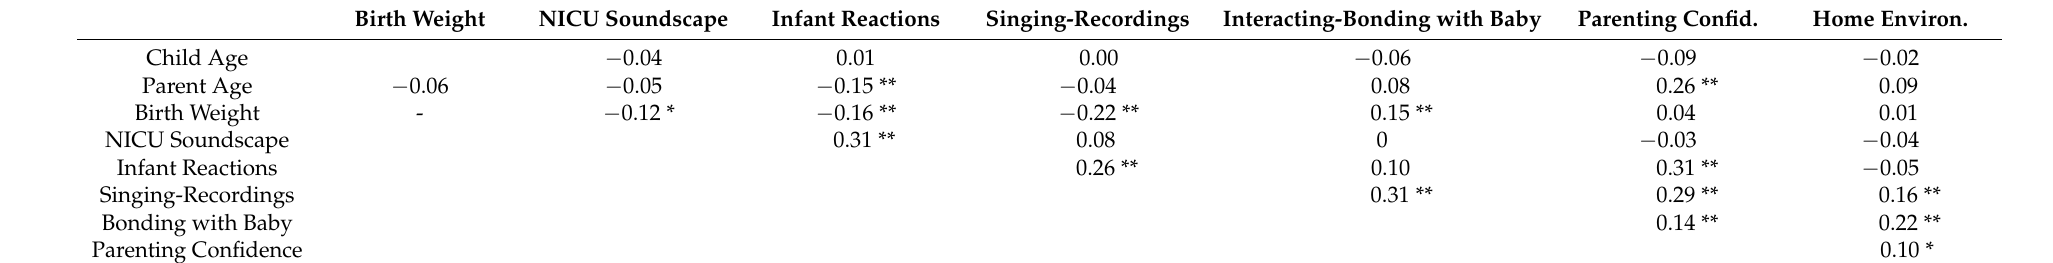
Table 4. Bivariate correlations between birth weight, parental age and all factors of the SON-Q. Birth Weight NICU Soundscape Infant Reactions Singing-Recordings Interacting-Bonding with Baby Parenting Confid. Home